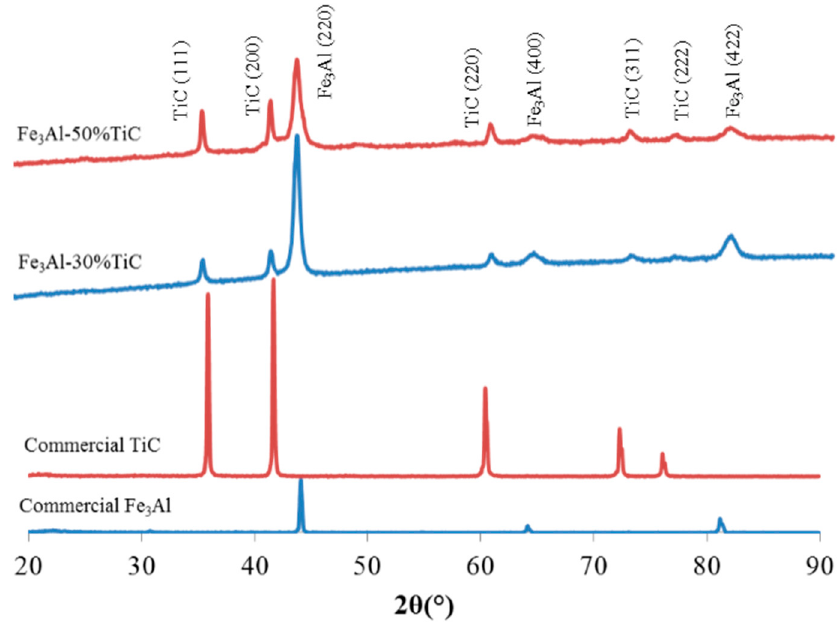
Figure 4. X-ray diffraction (XRD) patterns of the commercial starting powders and as-sprayed Figure 4. X ‐ ray diffraction (XRD) patterns of the commercial starting powders and as ‐ sprayed Fe 3 Al– Fe 3 Al–TiC TiC coatings.